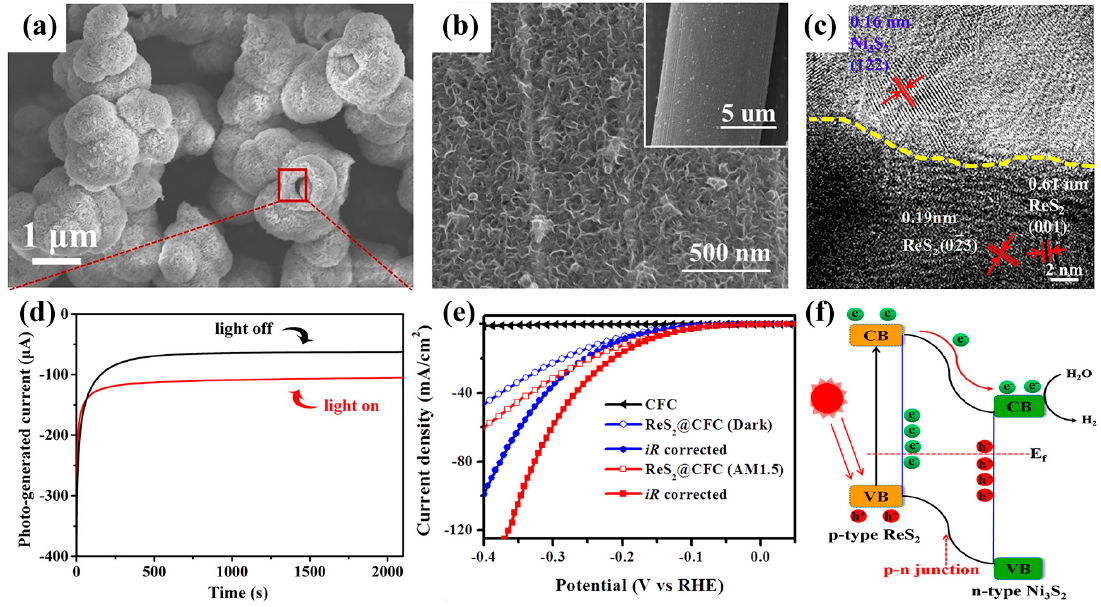
Figure 2. ( a ) SEM images of Ni 3 (VO 4 ) 2 and ( d ) time—dependent photocurrent responses curve under open circuit potential with/without visible light irradiation. Adapted with permission from ref. [61]. Copyright 2017, Royal Society of Chemistry. ( b ) SEM image and ( e ) LSV curves of ReS 2 @CFC. Adapted with permission from ref. [60]. Copyright 2018, Elsevier. ( c ) HRTEM image of ReS 2 /Ni 3 S 2 and ( f ) schematic diagram of photogenerated electron transfer path on ReS 2 /Ni 3 S 2 p-n heterojunction under light. Adapted with permission from ref. [64]. Copyright 2019, American Chemical